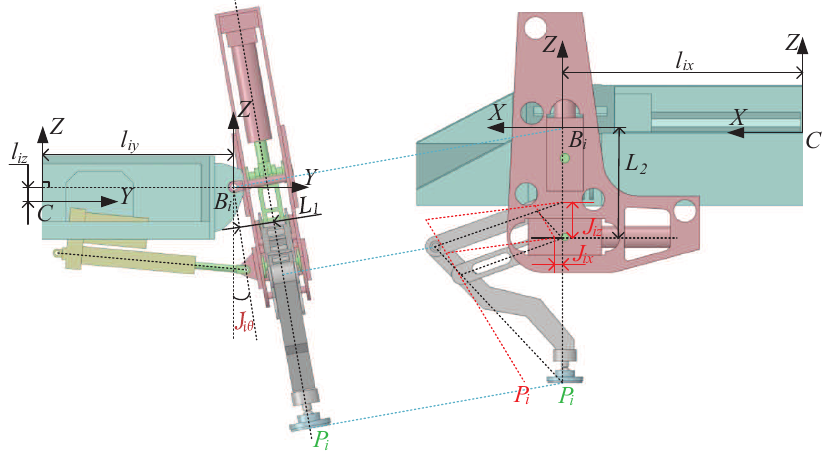
Figure 2. The schematic diagram of the robot leg structure and coordinate frame definitions of the hexapod